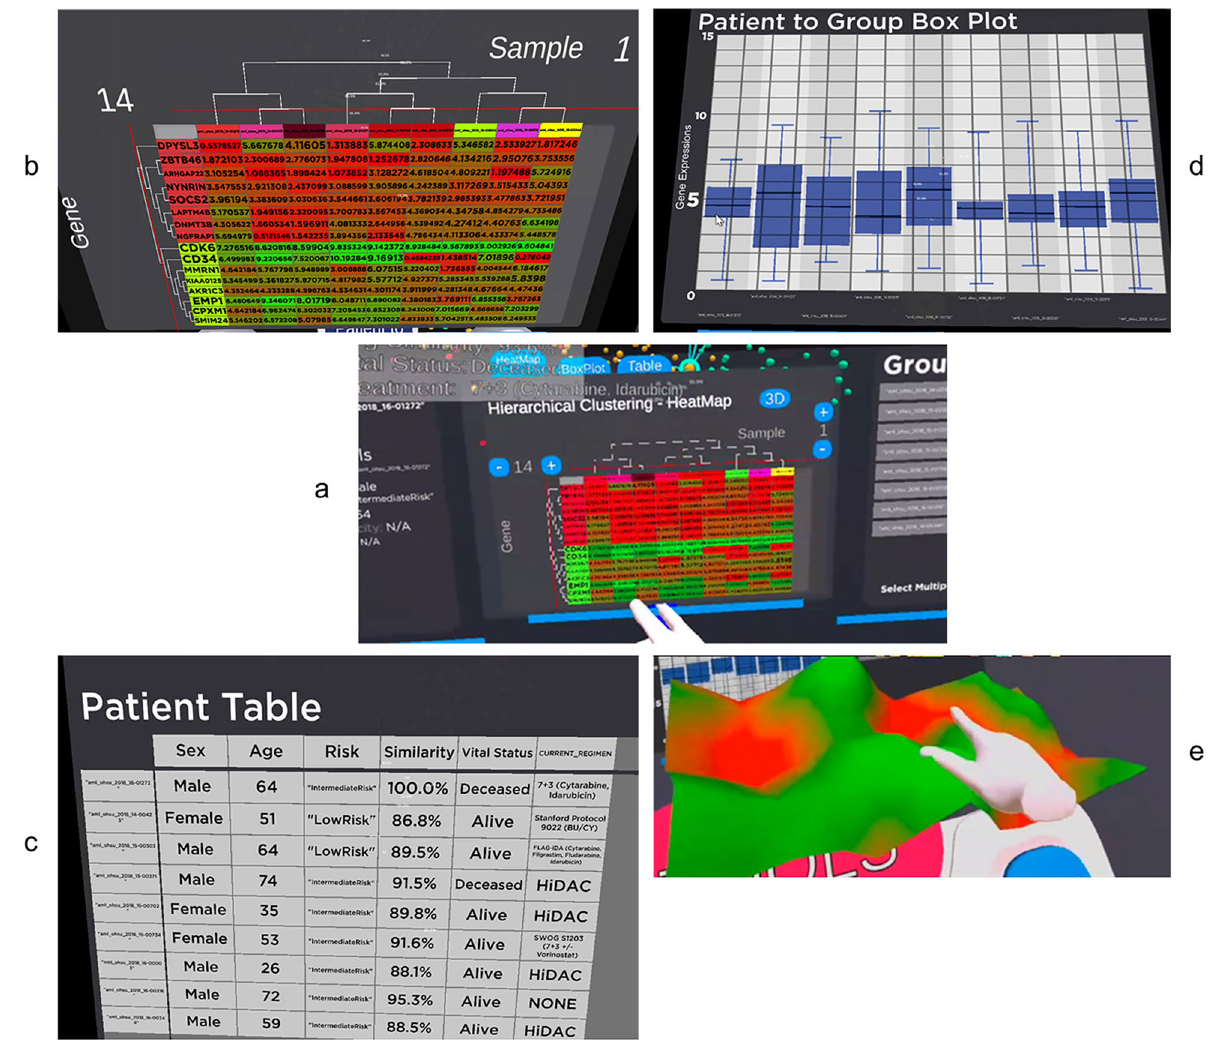
visualised in the heatmap. ( c ) Patients clinical history in tabular format. ( d ) The Box plot comparison of POI to POCs. The box plot shows the gene’s median and IQR for the POI and the POCS. ( e ) 3D visualisation of the heatmap with the gene expression value determines the height of the mountain and the